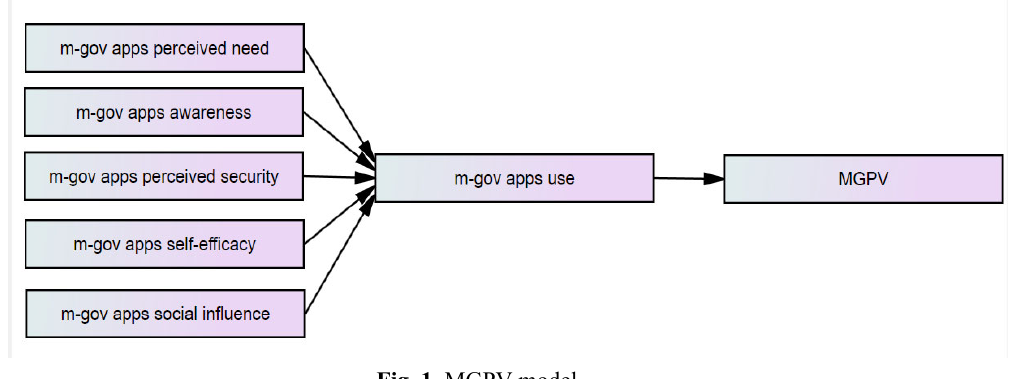
Fig. 1 . MGPV model